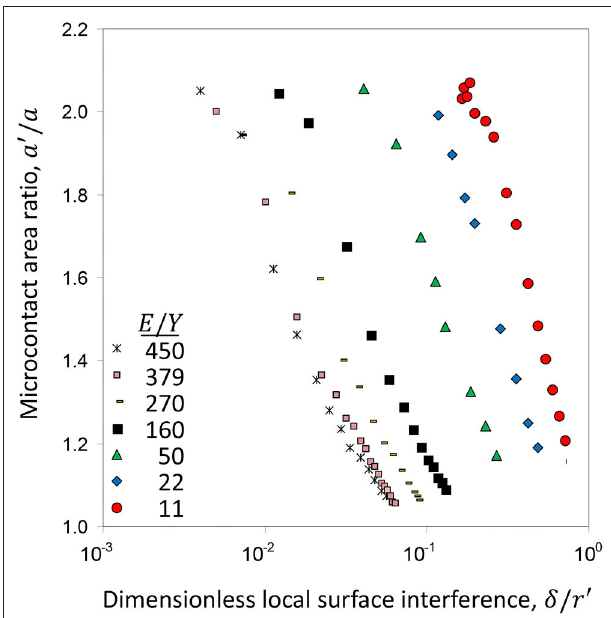
FIGURE 6 | Truncated-to-real contact area ratio a ′ / a vs. dimensionless local surface interference δ/ r ′ and effective elastic modulus-to-yield strength ratio E / Y ( Kogut and Komvopoulos,